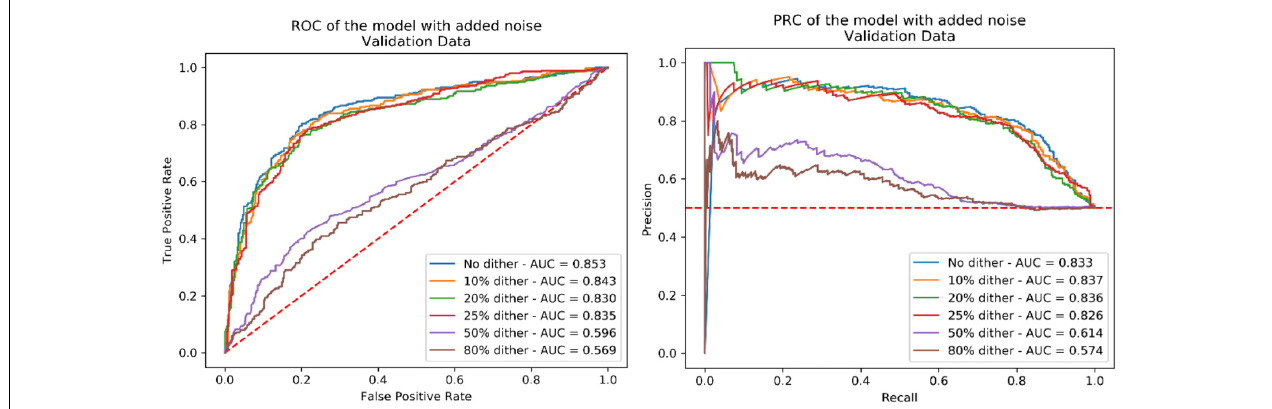
FIGURE 5 | The ROC (left) and PR (right) curves computed on the validation/test set. The AUC values are in the legend. The dashed lines in both graphs indicate the performance of a randomly guessing